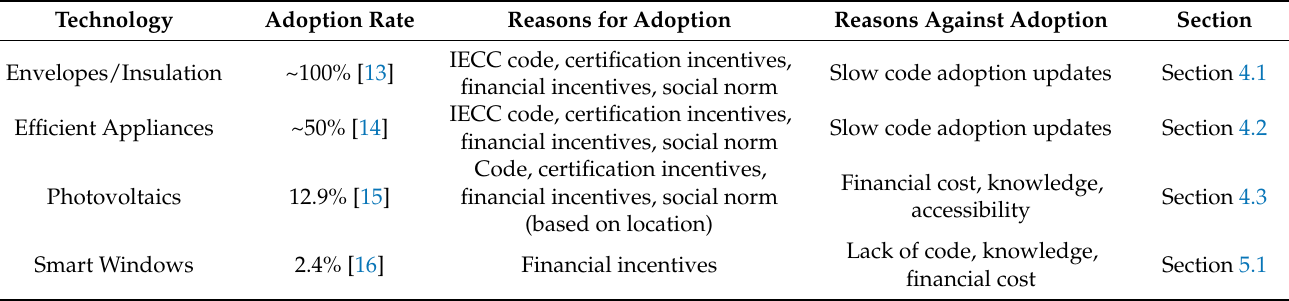
Table 1. Sustainable energy technologies considered in the review